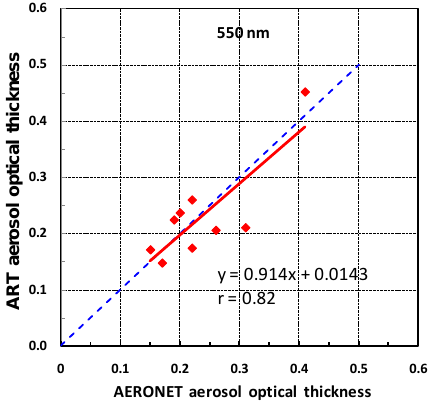
Fig. 8. The atmosphere transmission coefficient (21) versus Sun zenith angle. The atmosphere upper layer “2” has the molecular optical thickness τ mol = 0 . 3135 and contains aerosol H 2 SO 4 with τ = 0 . 0255; the lower layer “1” contains the Continental aerosol with optical thickness τ that is given in the legend. Computations with Eqs. (21–23) (dashed lines), the accurate computations with the RAY code (solid lines) are shown.